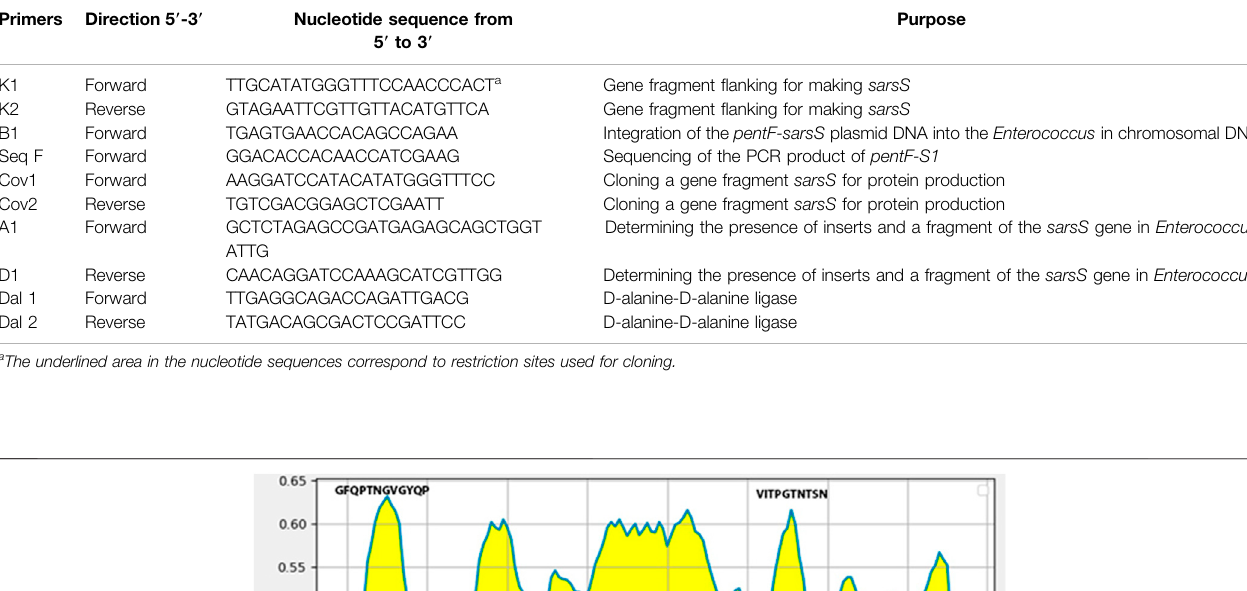
TABLE 1 | List of oligonucleotide primers used.